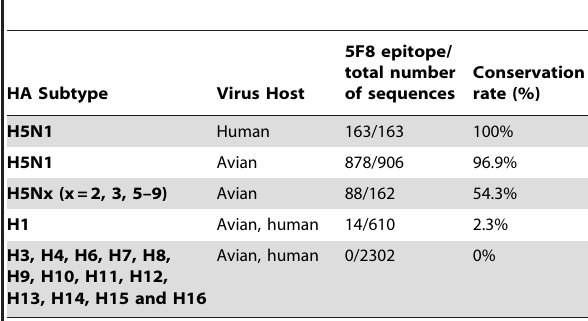
Table 3. Frequency of Monoclonal antibody 5F8 epitope among HA